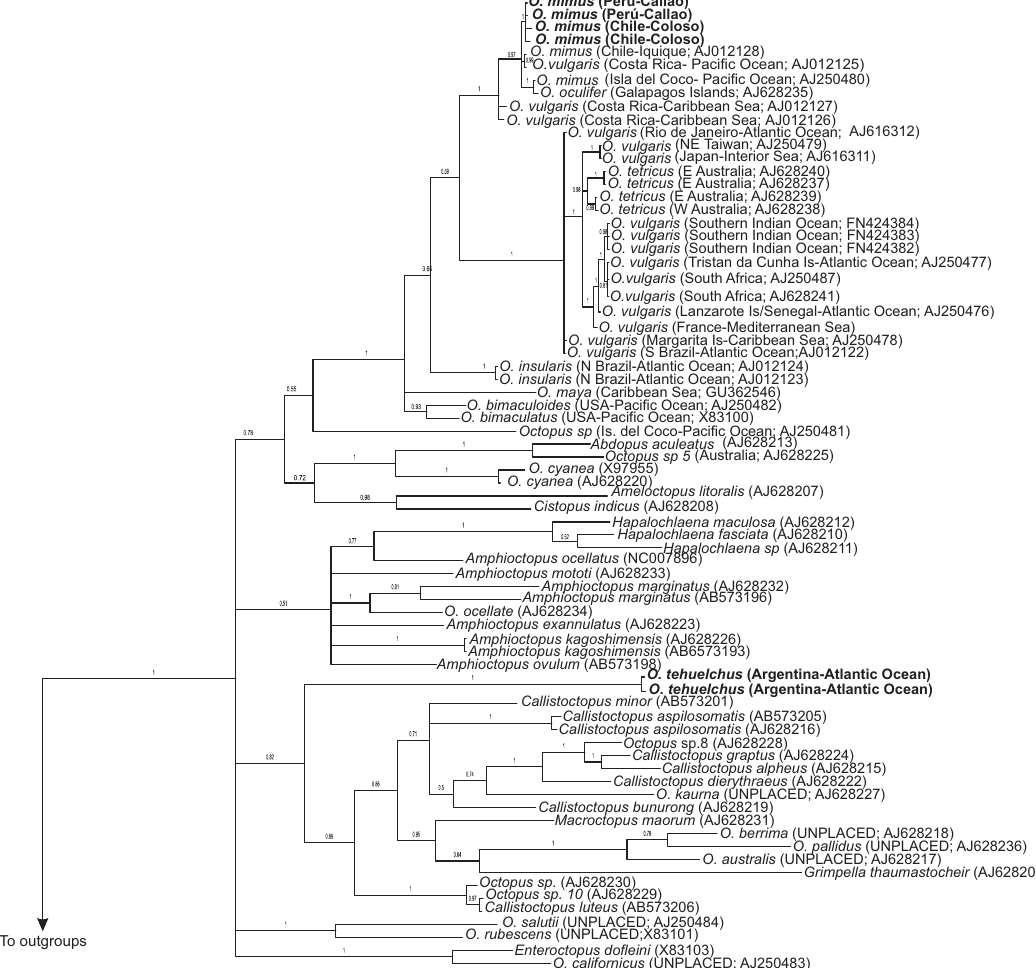
Fig . 1. – Phylogenetic relationships among species of the genus Octopus and other genera of the subfamily Octopodinae, estimated using COIII partial sequences and Bayesian inference, considering separate evolutionary models for each codon position. Loligo species ( L. vul- garis, L. forbesi and L. reynaudii ) were used as outgroups (not shown). Numbers on branches are the Bayesian posterior probabilities of the node to the right. Newly sequenced individuals are shown in